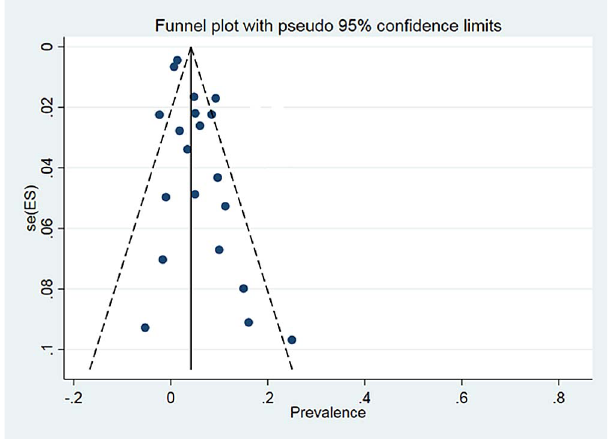
Figure 6. Meta regression chart of the proportion of resistance on the study